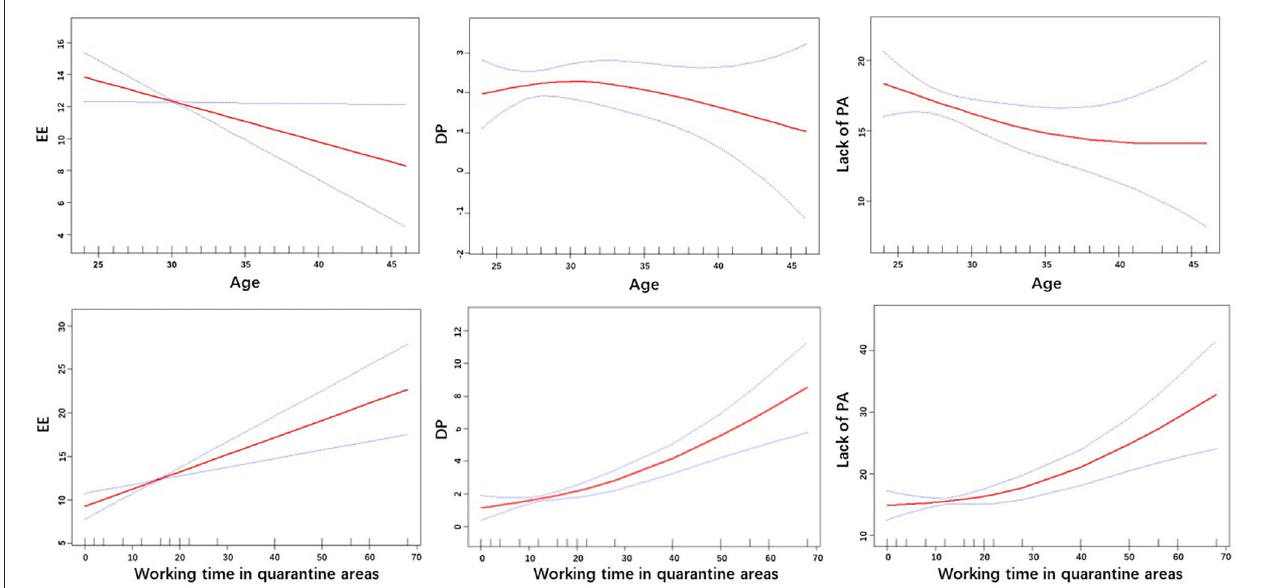
FIGURE 1 | Relationship between age, working time in quarantine areas, and three subscales of burnout. EE, Emotional Exhaustion; DP, Depersonalization; PA, Lack of Personal Accomplishment.